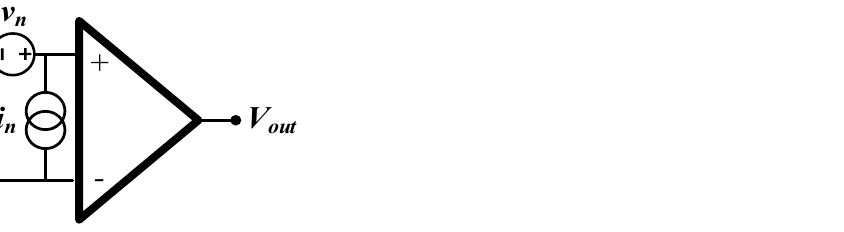
Figure 5. Noise equivalent circuit of the amplifiers. The input impedance of the amplifiers is assumed to be infinite.